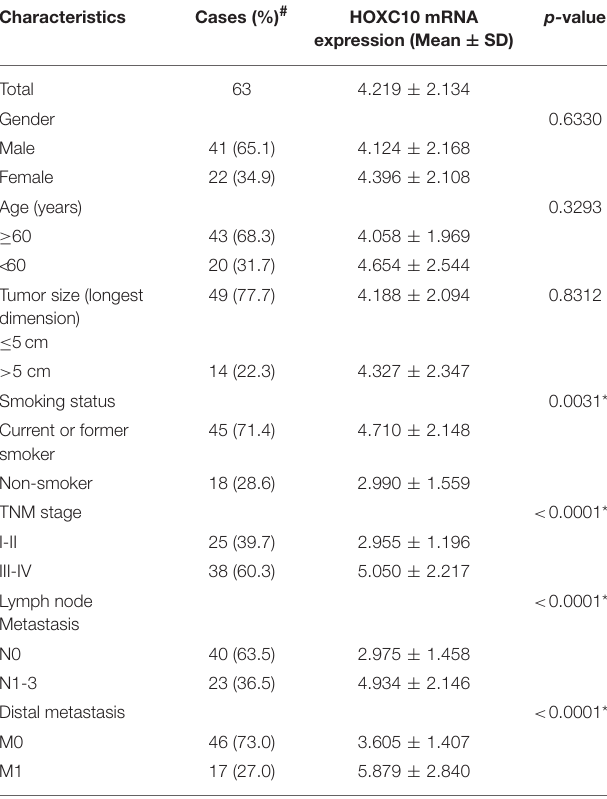
TABLE 1 | Clinicopathologic characteristics of lung cancer patients.